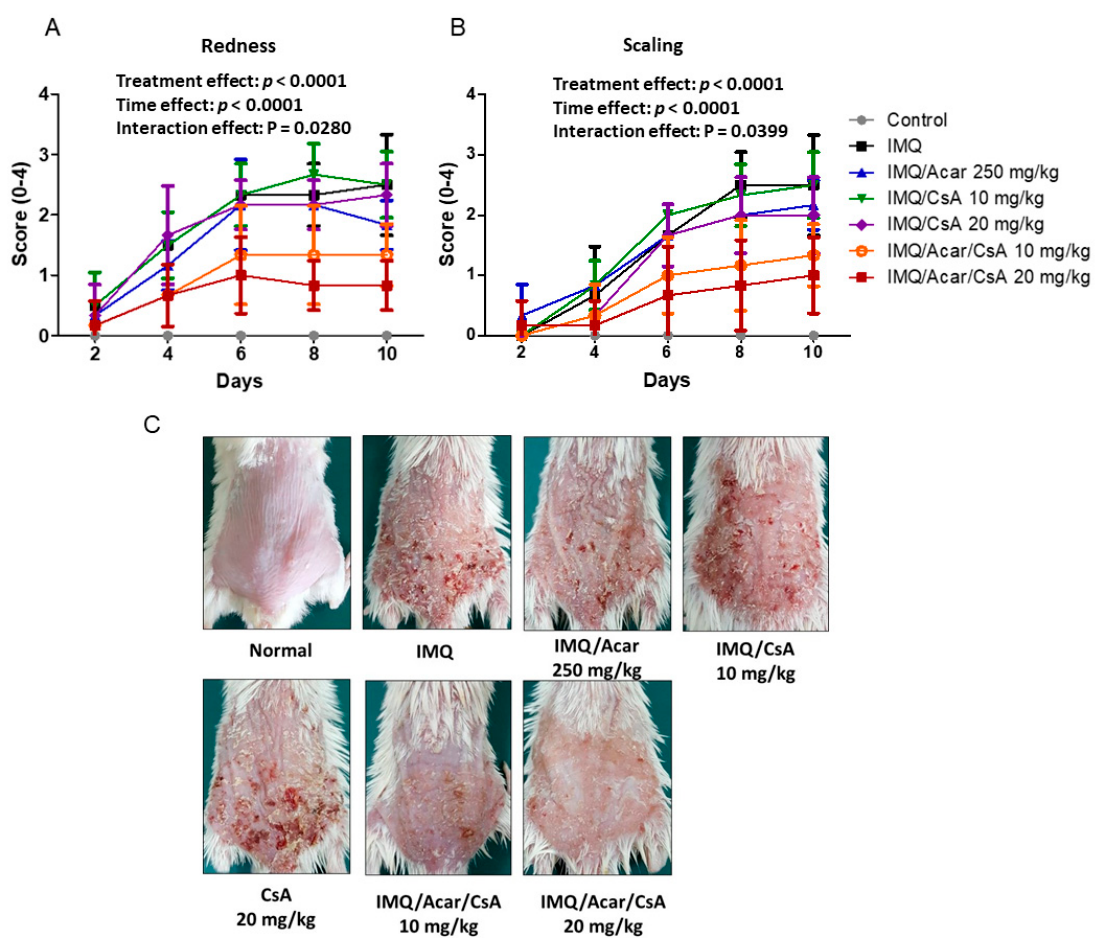
Figure 2. E ff ects of Acar (250 or 500 mg / kg) and / or low-dose CsA (10 or 20 mg / kg) on skin lesions of mice with IMQ-induced psoriasis-like dermatitis. E ff ects on symptoms of redness ( A ) and scaling ( B ); ( C ) representative images of the mice. time points. IMQ-induced mice and control mice received a daily dose of 62.5 mg of IMQ cream and control cream, respectively, on shaved back skin for 9 days consecutively. IMQ-induced mice were randomly assigned to one of the following six groups (n = 6): IMQ alone, Acar (250 mg / kg / day), CsA (10 mg / kg / day), CsA (20 mg / kg / day), Acar (250 mg / kg / day) + CsA (10 mg / kg / day), and Acar (250 mg / kg / day) + CsA (20 mg / kg / day). Acar was administered to the mice orally once a day for 9 days consecutively by gavage in 200 µ L of water, either alone or in combination with CsA. Experimental data are expressed as mean ± SD ( n = 6). A mixed design two-way ANOVA was also applied to the supplementation e ff ects within